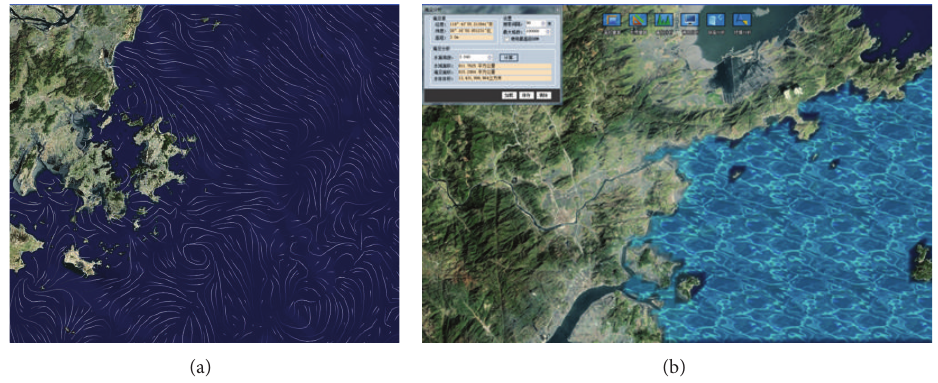
Figure 7: Current visualization (a) and water level/inundation visualization